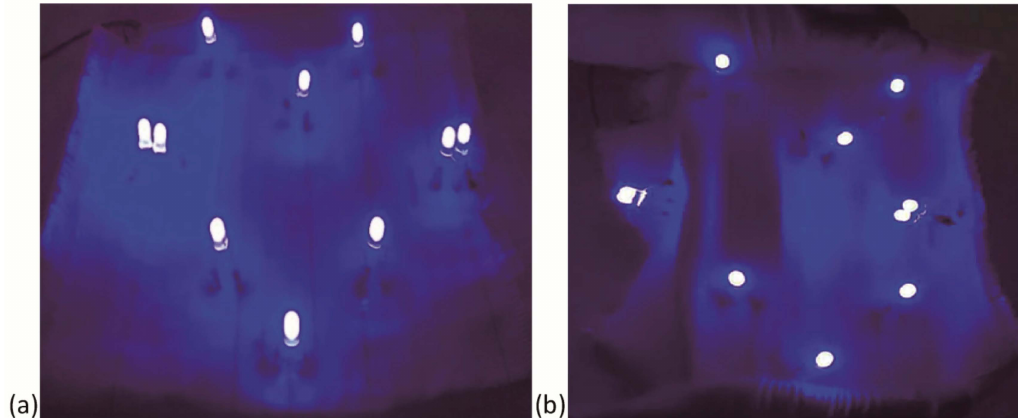
Figure 10. The created FCB assembly consisting of LEDs in the FCB substrate. ( a ) LEDs are illuminated at 0% strain; ( b ) LEDs remain illuminated at near 30%